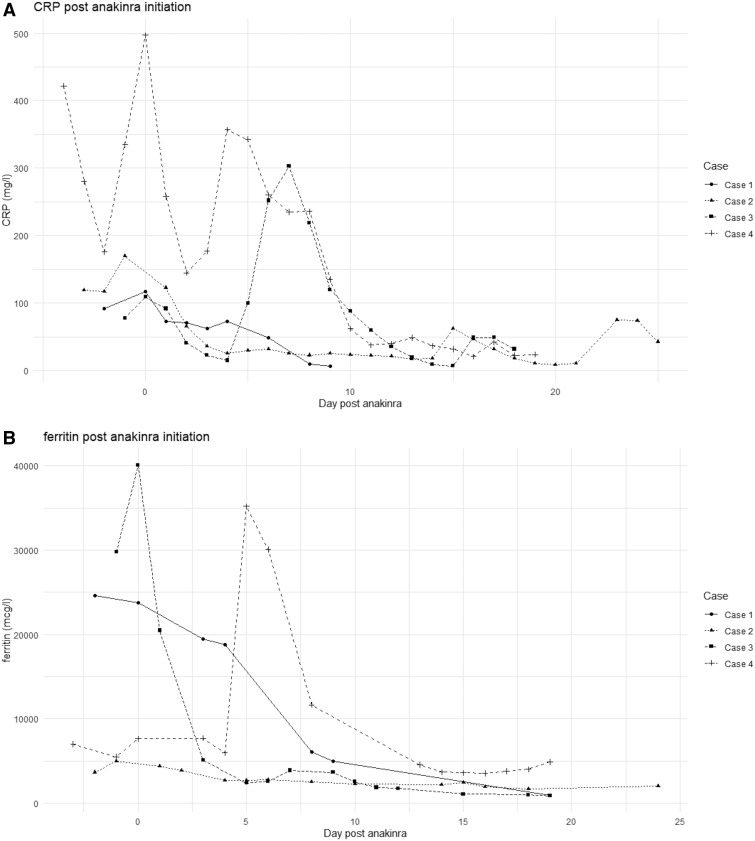
Graphs showing serum ferritin and CRP concentrations after initiation of anakinra for all four cases(A) Ferritin concentration (in micrograms per litre). (B) CRP concentration (in milligrams per litre).